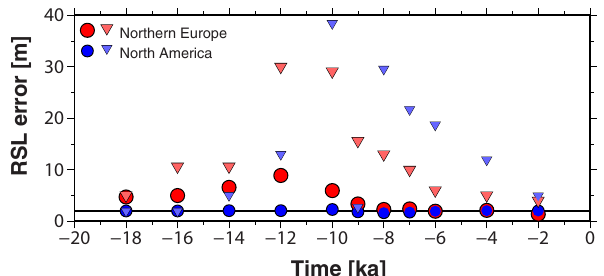
Figure 2. Average (circles) and maximum (inverted triangles) er- rors of relative sea-level data in North America (blue) and Europe (red) in time subsets of 1000 (between 10 and 6ka) or 2000 years. Average calculated as arithmetic mean. In total about 3700 were analyzed for this